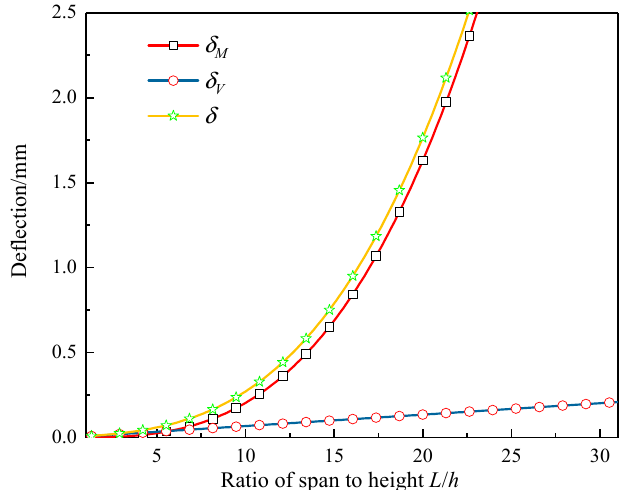
Figure 18. Curves of bending deflection δ M , shearing additional deflection δ V , and total deflection δ with the ratio of span to height L / H. with the ratio of span to height L /